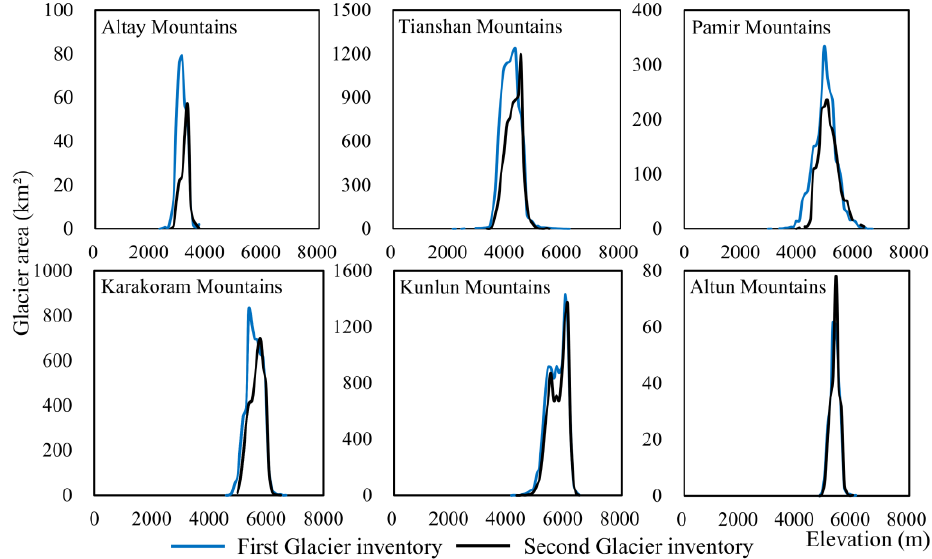
Figure 6. Hypsography of glacier area change in different mountains in